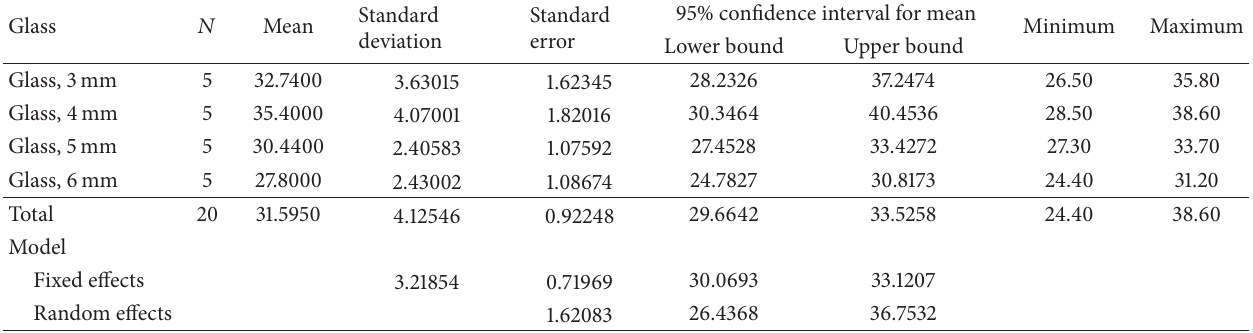
Table 2: Statistical analysis of performance of solar collectors with different glass thicknesses by using SPSS program.